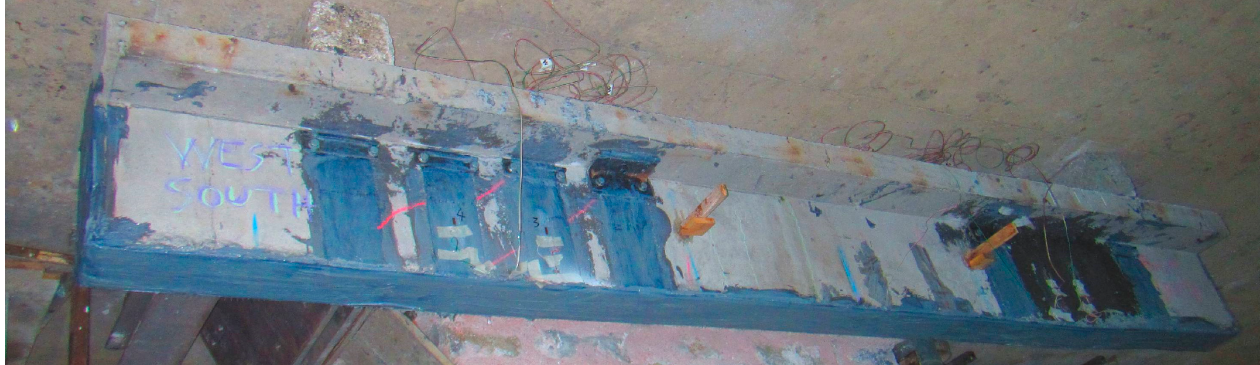
Figure 22. Comparison of the measured response between the prototype RC Virgin T-beam, this T-beam having been retrofitted with the 1 st , 2nd, and 3rd st rengthening schemes . ( a ) Shear force versus the deflection at mid-span. ( b ) Bending moment versus the deflection at mid-span. Figure 23. ( a ) The 3rd st rengthening scheme (West part). ( b ) The widening of the shear diagonal cracks and the partial crushing of the concrete volume in the anchoring region reduced considerably the effectiveness of this anchoring scheme.